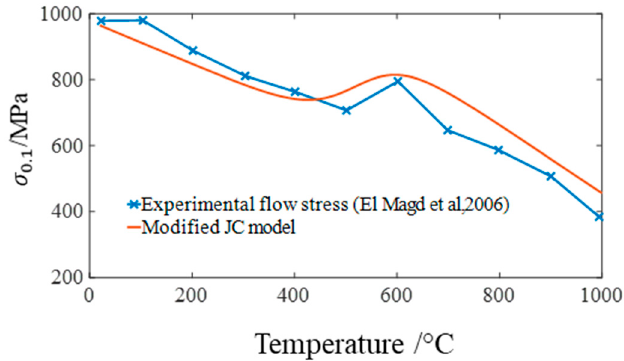
Figure 4. Experimental flow stress at 0.52 × 104 s − 1 from El Magd et al. [6] fitted using the MJC Model.